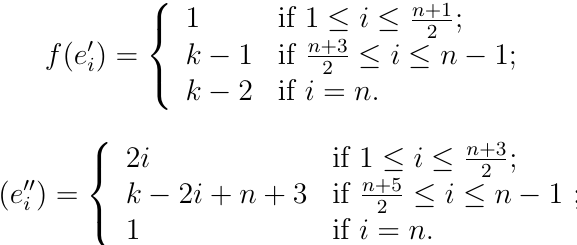
Figure 7: A Z k (cid:21)